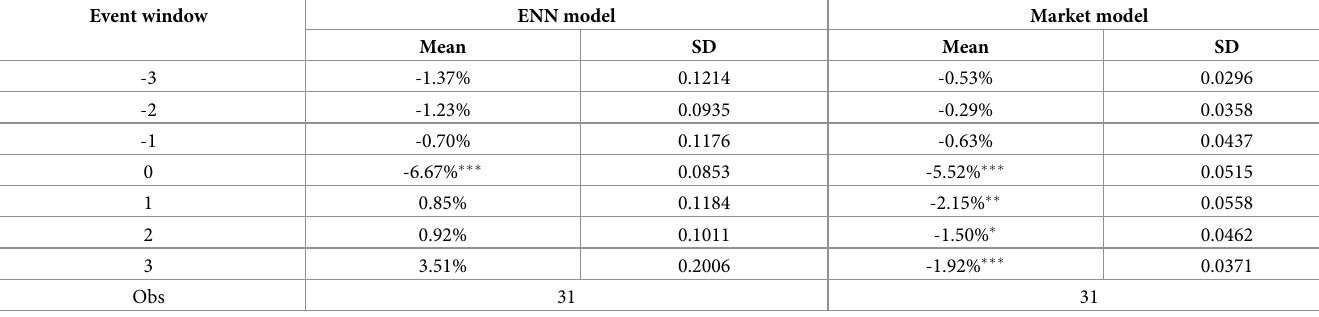
Table 5. ARs caused by the criminal detention announcement of controlling persons. Event